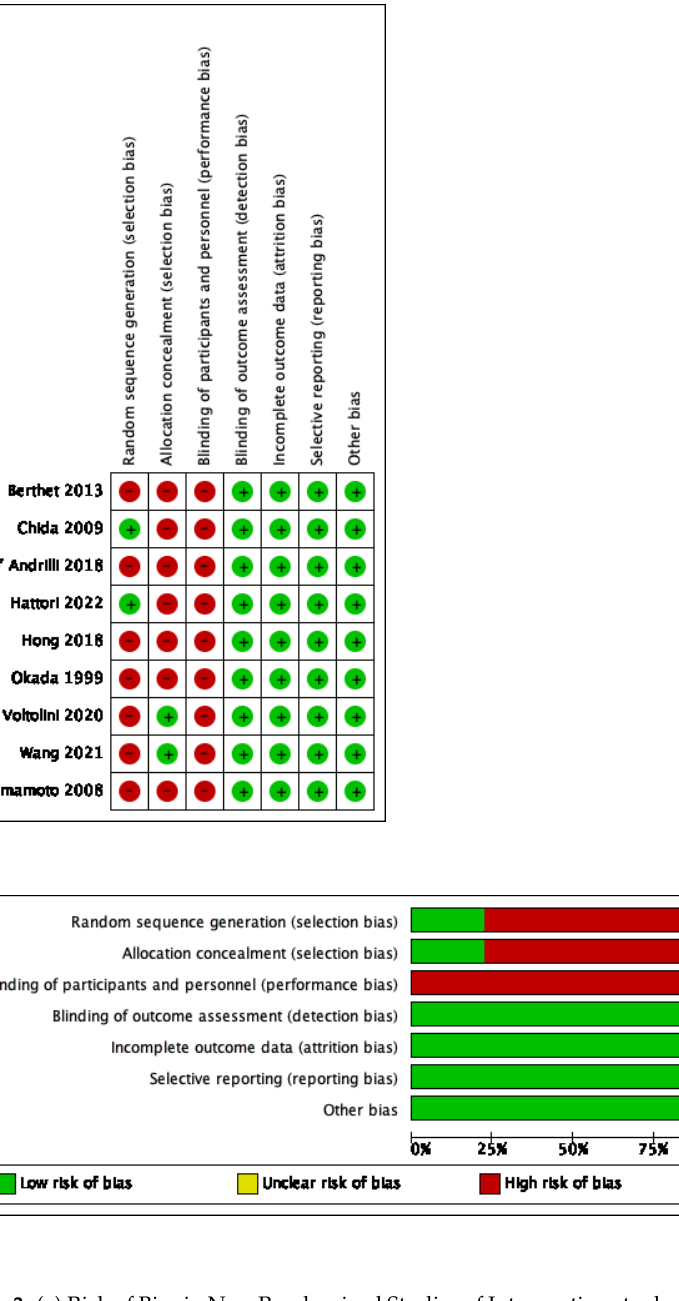
Figure 3. ( a ) Risk of Bias in Non-Randomized Studies of Interventions tool with traffic lights [4,10–17]. ( b ) Risk of Bias in Non-Randomized Studies of Interventions tool with summary